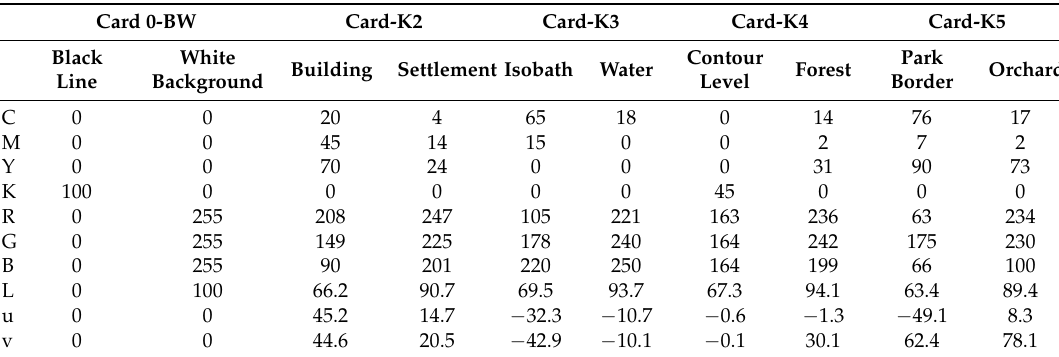
Table 5. Colours in the CMYK, RGB and CIELUV colour space used in the survey.